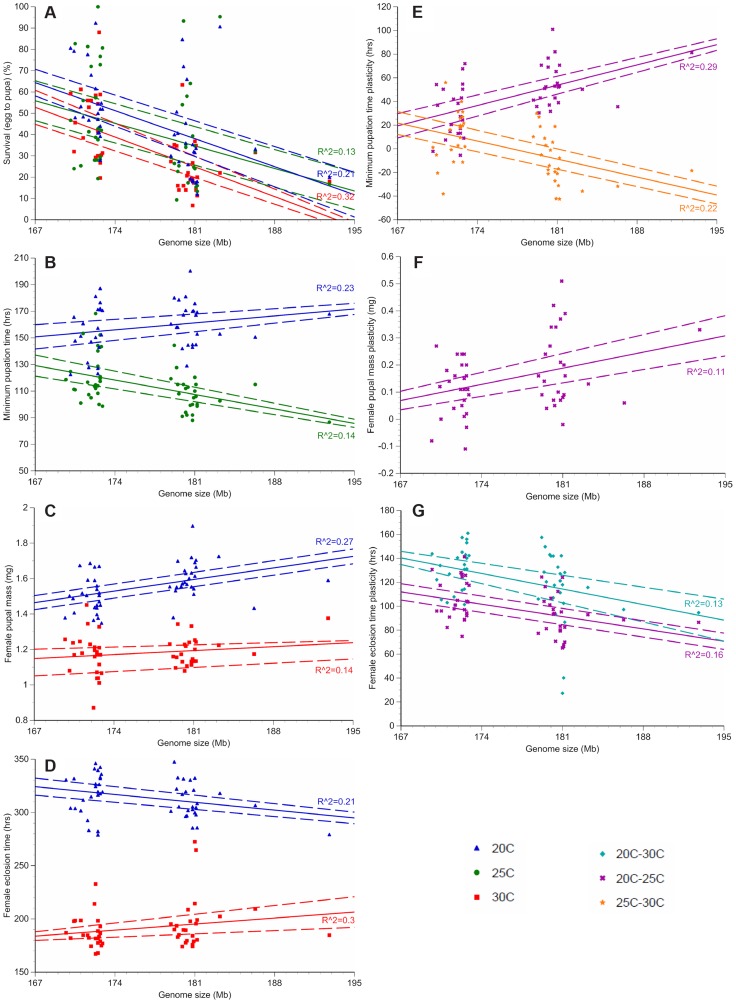
Genome size and temperature affect D. melanogaster development and plasticity.Only phenotypes with significant R
2 values (the proportion of variation in each phenotype due to genome size variation, not accounting for other genetic effects) are depicted. The average survival to pupation (A), minimum pupation time (B), female pupal mass (C) and female eclosion time (D) is shown for the 25 strains with the largest and smallest genomes at 20°C (blue triangle), 25°C (green circle), and 30°C (red square). Plasticity for minimum pupation time (E), female pupal mass (F) and female eclosion time (G) is shown between 20°C and 30°C (turquoise diamond), 20°C and 25°C (purple x) and 25°C and 30°C (orange star). Dashed lines represent 95% confidence intervals of the regression line.